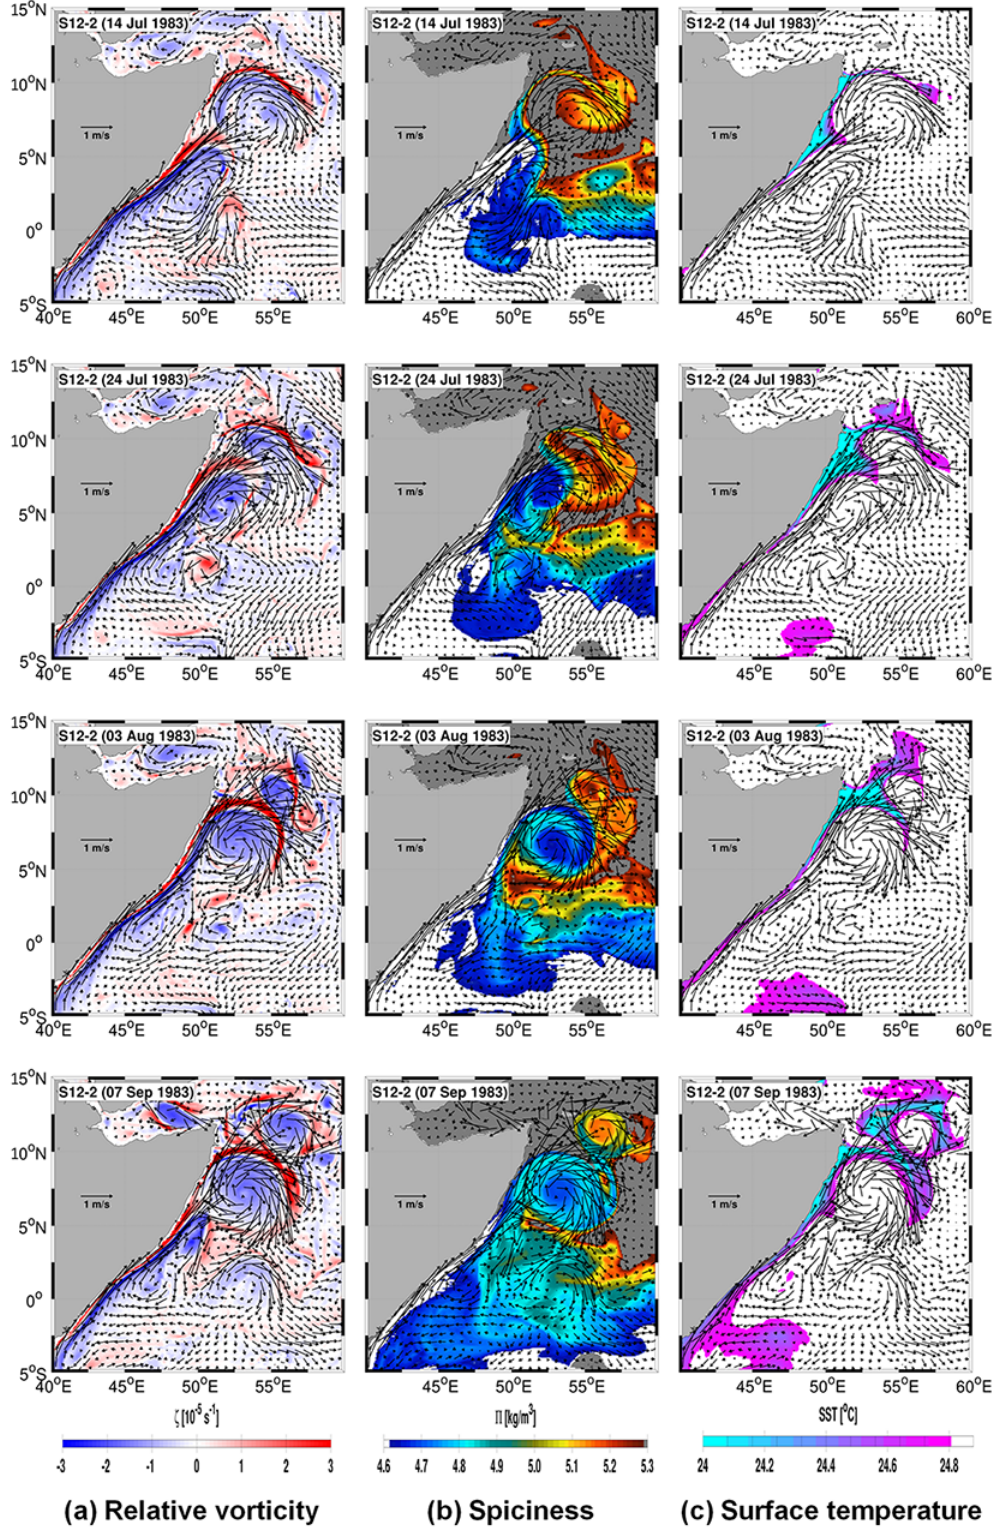
Figure 5. Sequence of snapshots describing the most frequent scenario during the well-established Southwest Monsoon period. Surface cur- rents (vectors; ms − 1 ) are superimposed on (a) the relative vorticity ( ζ ; colour shading; s − 1 ) at depth 50m, (b) the spiciness on σ = 23.8 ( (cid:53) ; colour shading; kgm − 3 ), and (c) the sea surface temperature (SST, colour shading, ◦ C). This sequence is from the 1 / 12 ◦ S12-2